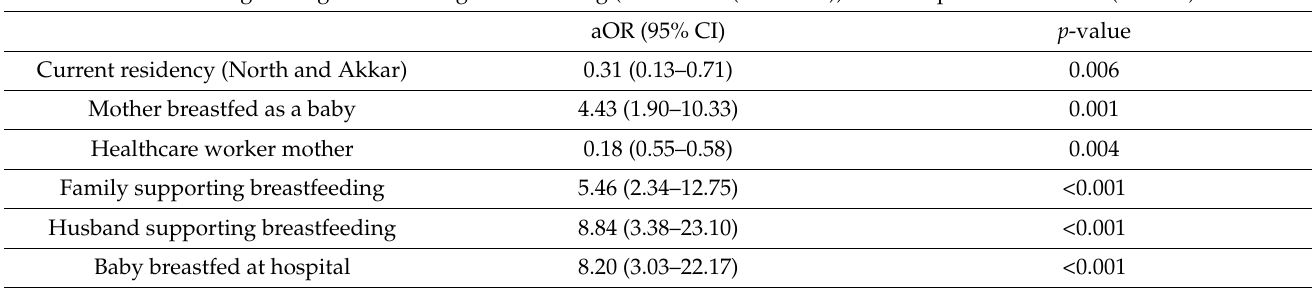
Table 5. The results of the multivariate analyses for the association of feeding pattern (breastfeeding, bottle feeding, and complementary feeding), and sociodemographic and behavioural